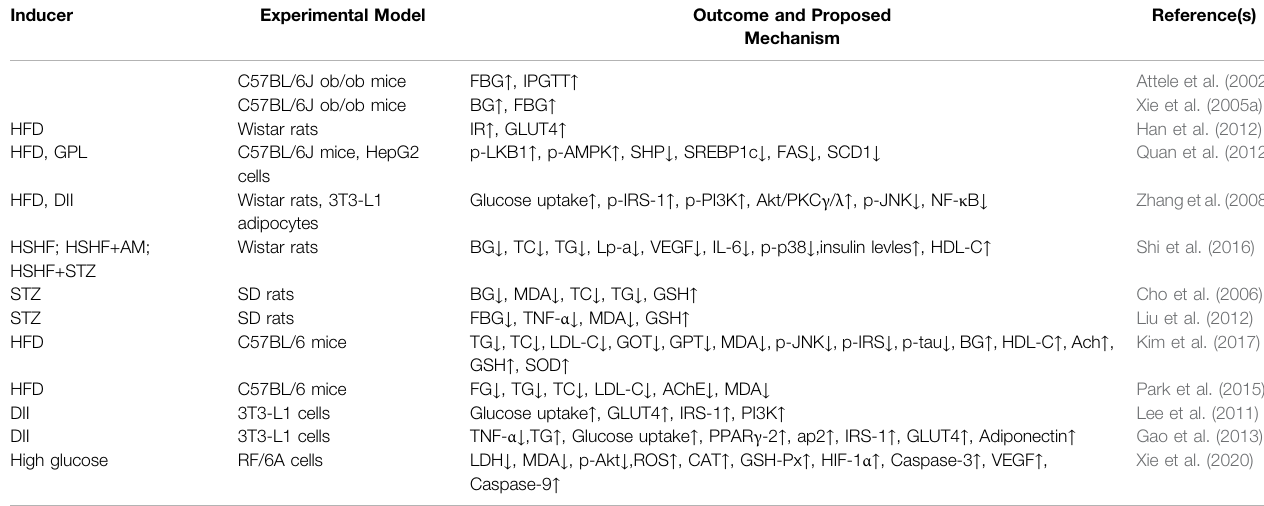
TABLE 1 | Summary of anti-diabetes effects of Re.